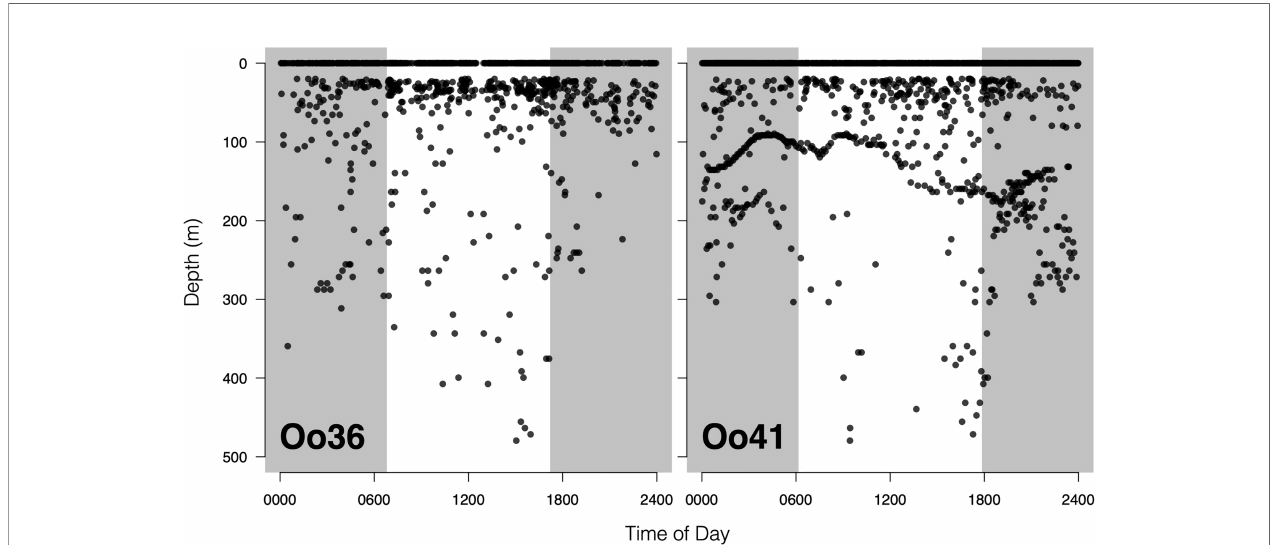
FIGURE 5 | Offshore killer whale dive activity plotted as function of time of day. Shaded areas are periods of dark, de fi ned by the mean sunrise time and mean sunset time during the deployment. The lack of activity between 1 and 20 meters is a function of tag programming, which considers all dives shallower than 20m as ‘ surface ’ time. The striking undulating pattern in dive depths for Tag Oo41 is likely a response to local sea fl oor